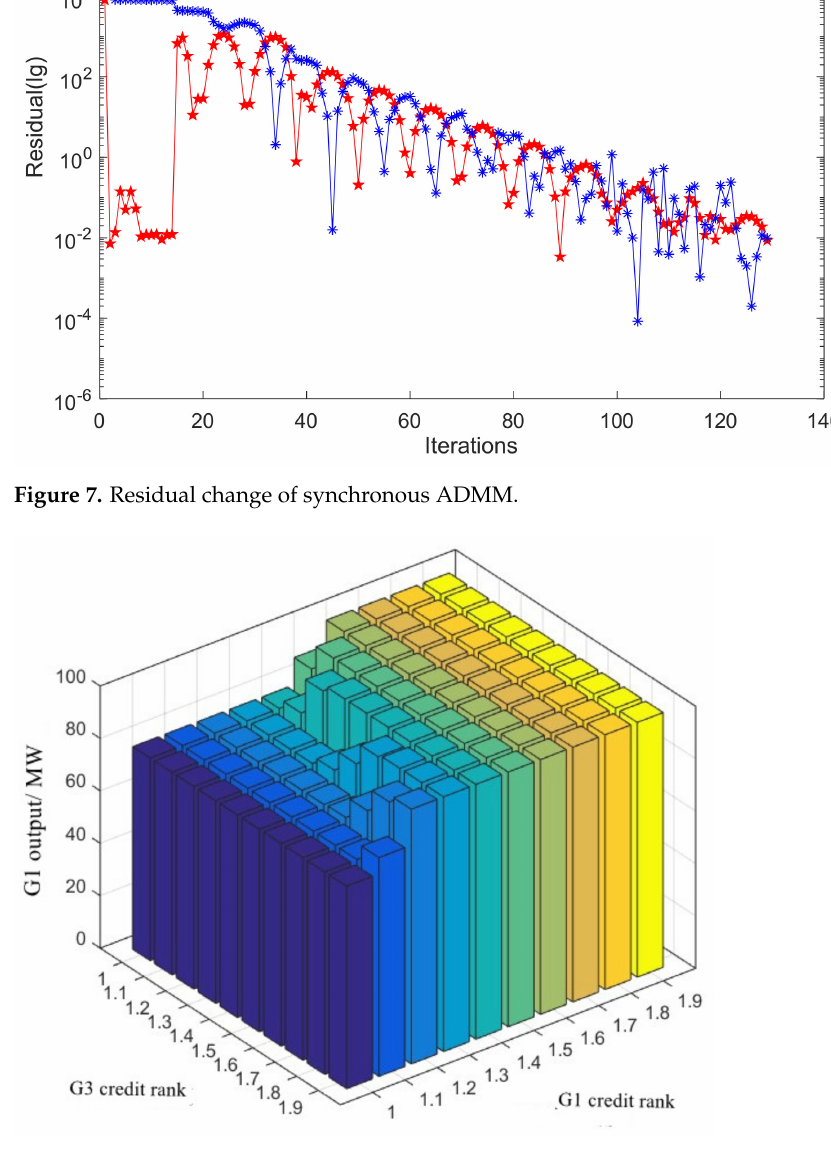
Figure 8. Residual change of synchronous